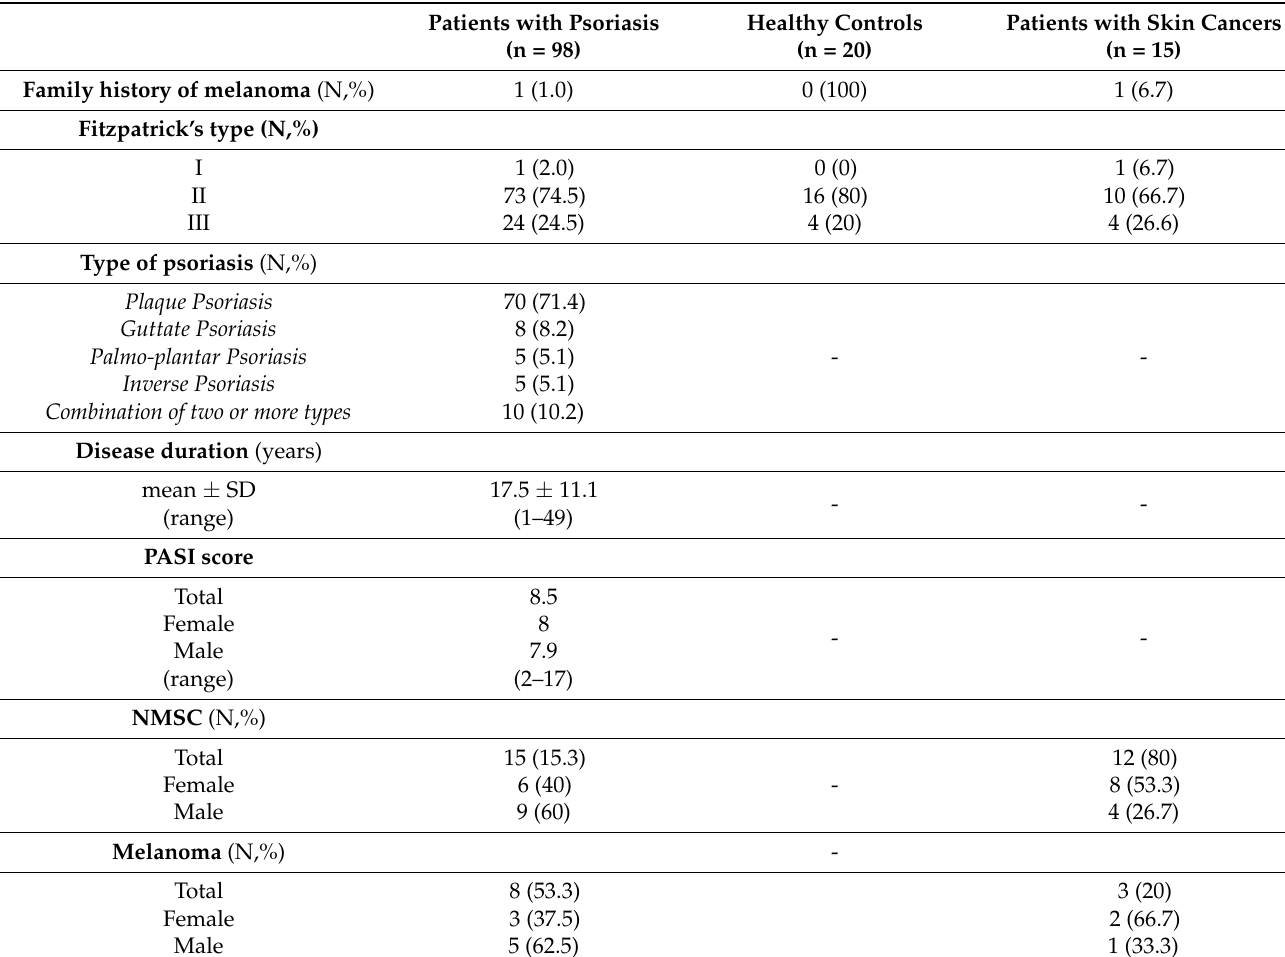
Table 1. Cont. Patients with